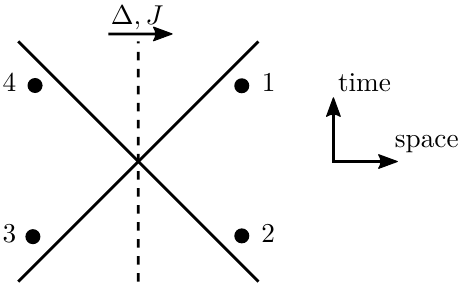
[ G ] in the Rindler positive kinematics of fig- s ( η ) with ν large 2 − d + iν 2